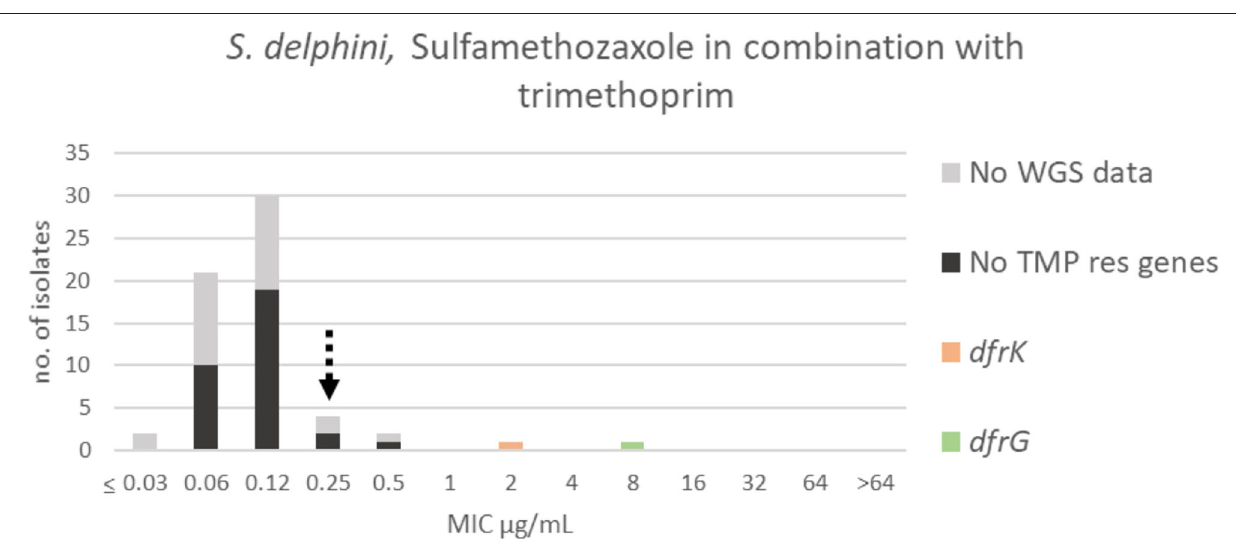
MIC values of 0.25 and 2 µ g/mL, respectively, and since the ECOFF for the closely related species S. pyogenes ( Table 4 ) and S. pneumoniae is 0.5 µ g/mL (13). Consequently, a TECOFF was not proposed.